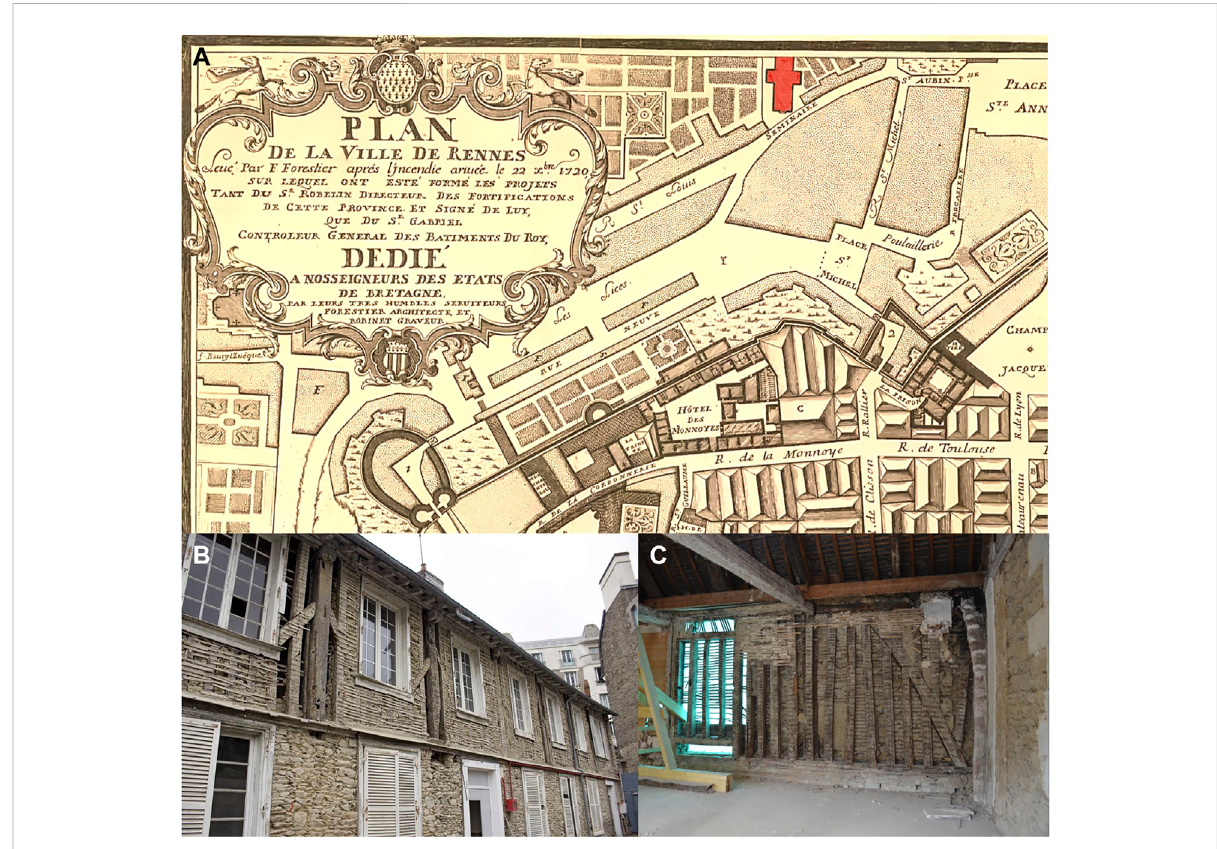
FIGURE 5 Location ofthebuilding (inred)as achapel onaplanmadeafter the fi reinRennes in1720Andrieux,(2021) (A) /interior (B) andexterior (C) views Ferrette and Esnault,